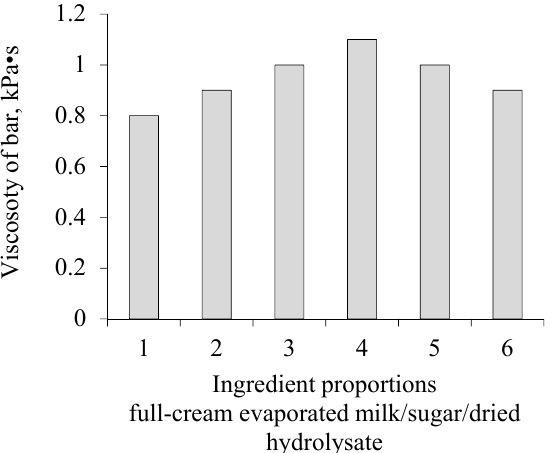
Fig. 3. Dependence of bar viscosity on ingredient proportion at 30°C (1 – 100 : 43 : 2; 2 – 105 : 38 : 2;